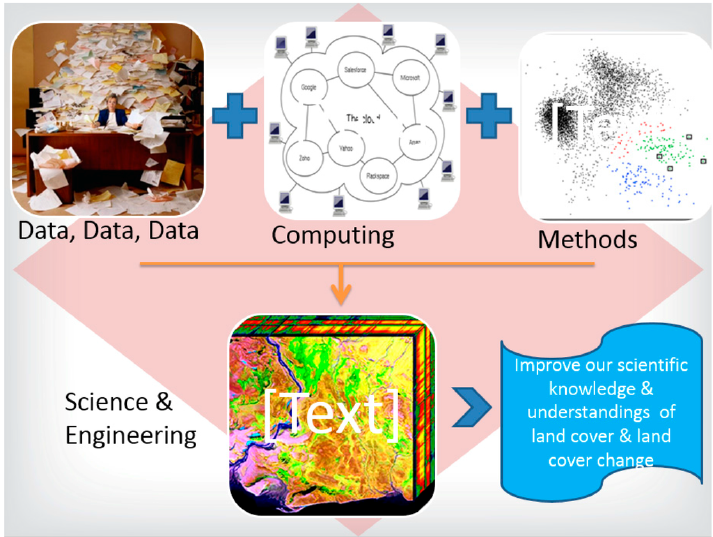
Figure 2. Conceptual diagram of the integration of data, computing, and methods using science and engineering to improve our scientific understanding of mangrove forest cover change. Pre-processing of satellite data should be centralized, whereas classification and im- age interpretation can be decentralized (Figure 3). However, there should be an inflow of information from centralized to local levels and vice versa.